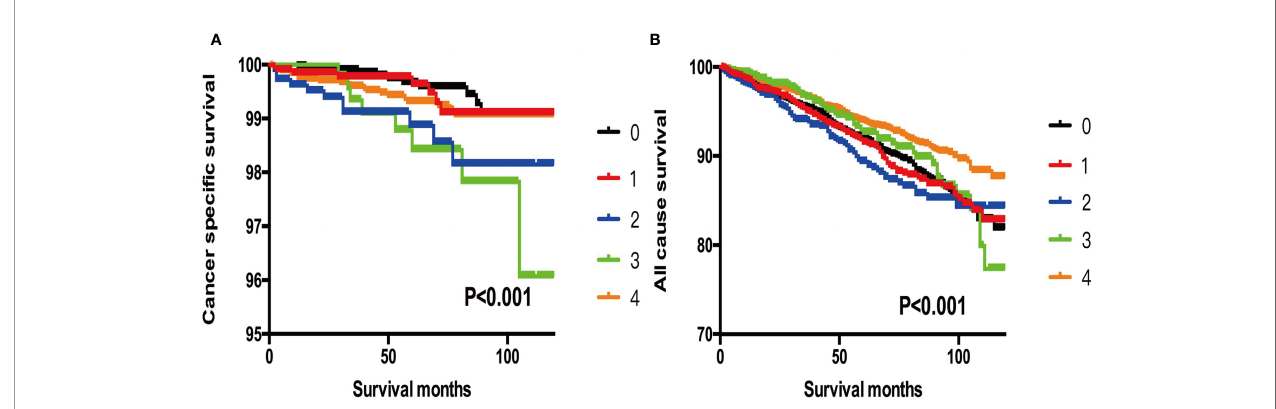
FIGURE 3 | (A) Kaplan-Meier curves among patients strati fi ed by tumor size for cancer-speci fi c mortality (Log rank test, p < 0.001). 0 For patients with thyroid cancer>4 cm and without gross extrathyroidal extension (clinical T3) and no clinically apparent metastatic disease to nodes (clinical N0) and no distant sites (clinical M0). 1 Male, > 45 years old, tumor size 0-1 cm. 2 Male, > 45 years old, tumor size 1-2 cm. 3 Male, > 45 years old, tumor size 2-3 cm. 4 Male, > 45 years old, tumor size 3-4 cm. (B) Kaplan-Meier curves among patients strati fi ed by tumor size for all-cause mortality (Log rank test, p < 0.001). 0 For patients with thyroid cancer>4 cm and without gross extrathyroidal extension (clinical T3) and no clinically apparent metastatic disease to nodes (clinical N0) and no distant sites (clinical M0). 1 Male, > 45 years old, tumor size 0-1 cm. 2 Male, > 45 years old, tumor size 1-2 cm. 3 Male, > 45 years old, tumor size 2-3 cm. 4 Male, > 45 years old, tumor size 3-4